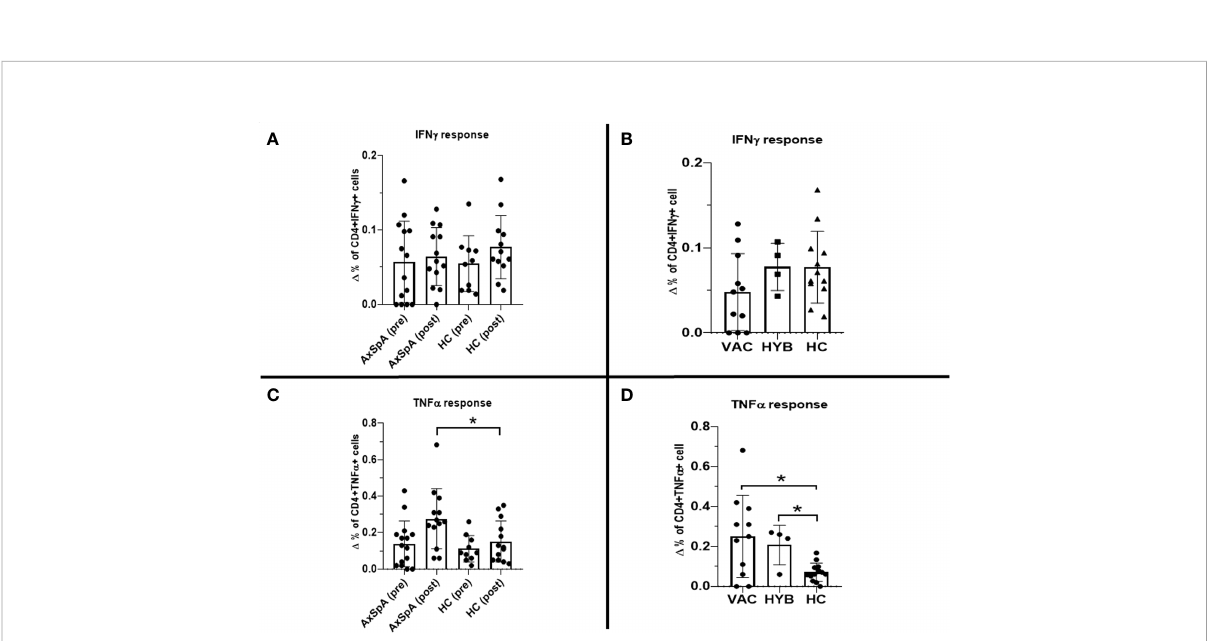
FIGURE 5 Pre-dose (6 months after primary vaccination scheme) and post-dose (1 month after booster vaccination) Interferon gamma (IFN g ) T – cell immune response measured as difference in the production of intracellular cytokine production between stimulated and unstimulated (A) : D CD4+IFN g +; (C) : D CD4+TNF a +) cells in axial spondyloarthritis (AxSpA) patients and in healthy controls (HC), “ vaccinated only ” AxSpA (VAC), hybrid immunity ” AxSpA (HYB) cohorts respectively (B, D) ; statistically signi fi cant differences marked as *p <